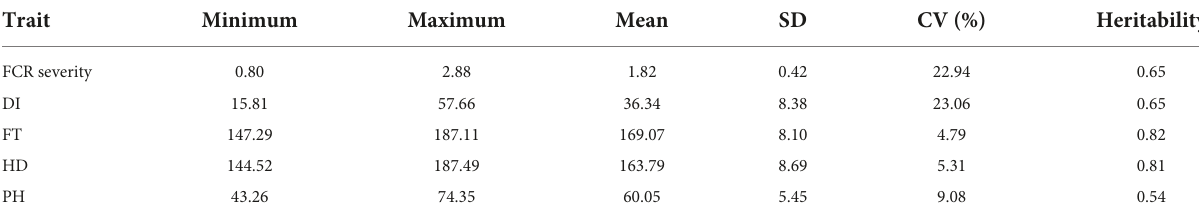
TABLE 2 Phenotypic variations and heritability of disease index, flowering time, heading date, and plant height. Trait Minimum Maximum Mean SD CV (%) Heritability